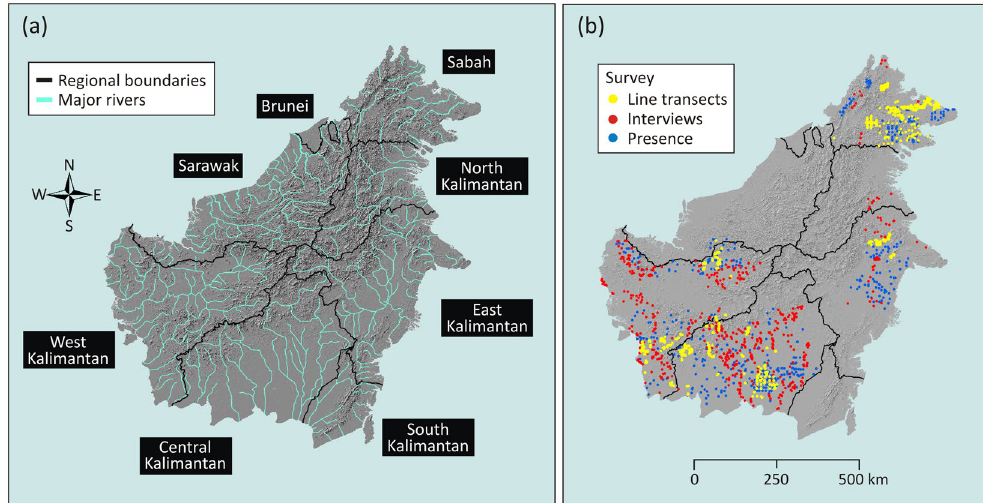
Figure 5. Maps of the study area and orangutan surveys. A topographic map of Borneo with regional boundaries and rivers, derived from the SRTM digital elevation data 67 district maps provided by the Indonesian Geospatial Information Agency 68 and GADM database of Global Administrative Areas 69 and river networks provided by the HydroSHEDS 70 and visual inspection via Google Earth ( a ). The locations of orangutan surveys conducted over the last two decades: line transect surveys of orangutan nests (ground and aerial), interview surveys of direct orangutan sightings, and presence points of nest and individual sightings ( b ). These maps are available at